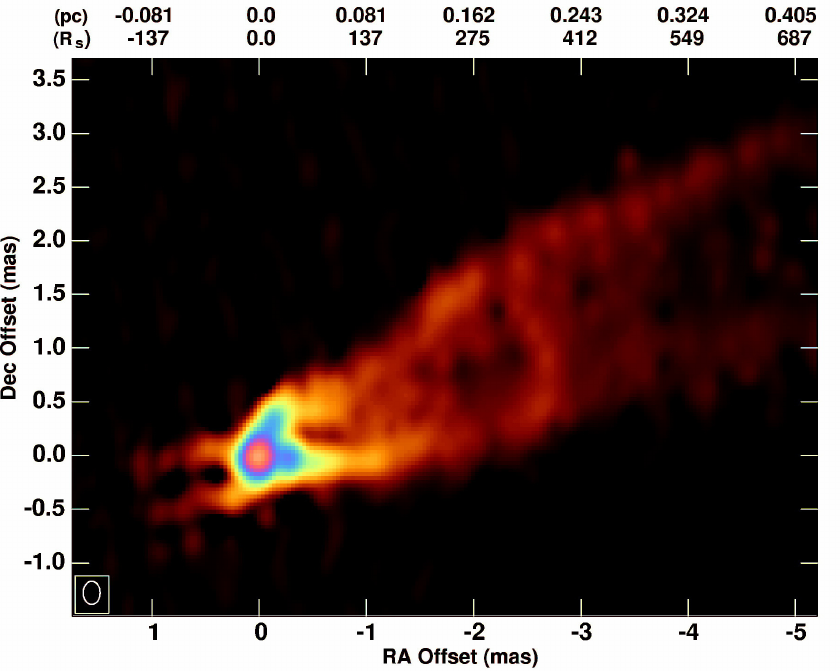
Figure 2. An image of the inner portions of M87 based on the same 12 January 2013 data used for Figure 1, but made with uniform weighting to maximize resolution, and then superresolved by 30% in the N-S direction (convolved with a Gaussian beam that is 30% smaller than the central peak of the point spread function). The convolving beam used is 0.158 × 0.215 mas elongated along position angle 0 ◦ . The axes are mas from the core. The higher resolution helps delineate the structure close to the core, and emphasizes the symmetry between the jet and counterjet. Note that the sharp kink in the northern ridge at about 0.6 mas from the core is not a lasting feature of the